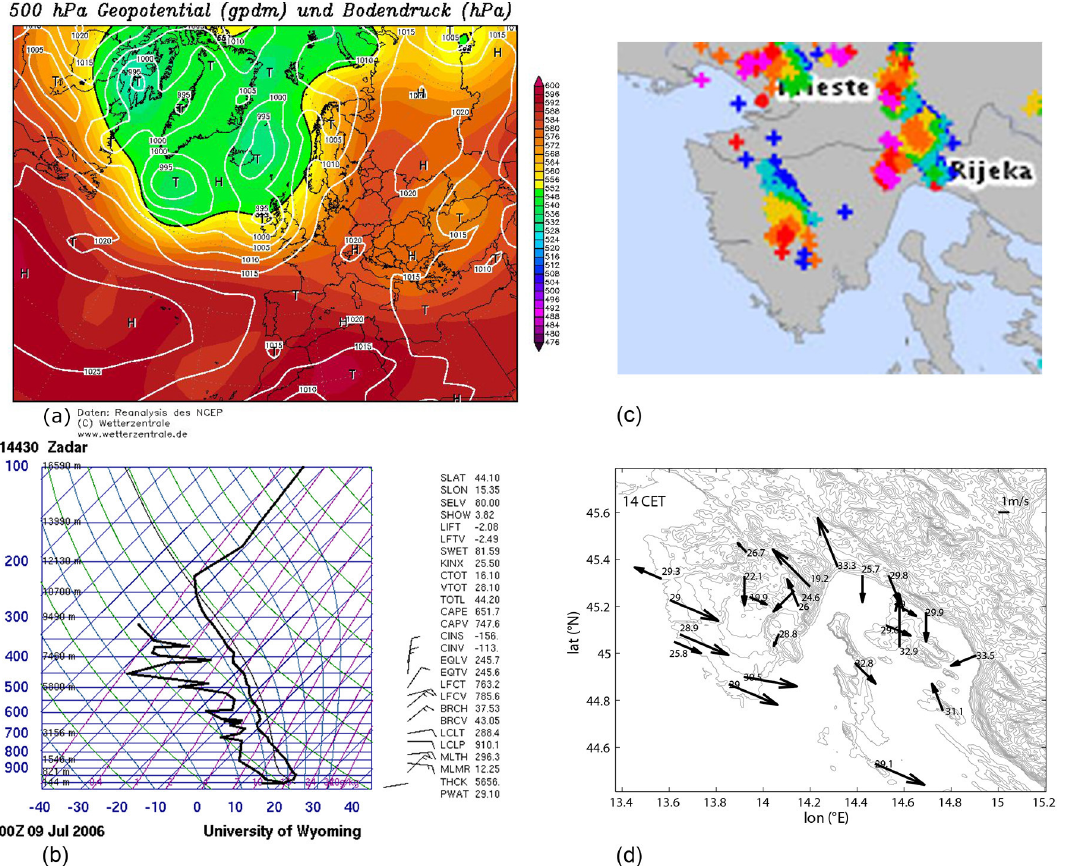
Fig. 3. Case C1, 9 July 2006: (a) surface pressure distribution (white lines) and geopotential of 500hPa pressure level (filled areas) at 00:00UTC (i.e. 01:00CET) (source: http://www.wetterzentrale.de/topkarten/fsreaeur.html). (b) Radio sounding profiles plotted on a skew T- log p diagram in combination with convective indices in Zadar (44.10 ◦ N, 15.35 ◦ E) at 00:00UTC (i.e. 01:00CET); (c) lightning distribution from 13 to 14:00CET from LINET network (Betz et al., 2009). The coloured crosses indicate the detection of lightning within one hour: purple (<3min), red (10–3min), orange (20–10min), yellow (30–20min), green (40–30min), light blue (50–40min) and blue (>50min); (d) the measured 10m wind vectors (ms − 1 ) and 2m air temperatures ( ◦ C) at 14:00CET (measuring sites in Fig. 1a). Table 2. Sea breeze (SB) characteristics and thermodynamical variables from the model averaged in time (for period of 10:00–12:00CET), over the Istria peninsula for four selected cases. Parameters were defined along the vertical cross-section (B1B2) shown in Fig. 1. In the table, abbreviations represent max SB speed=maximum wind speed in the western onshore flow usually between 200 and 300ma.g.l, SBF: sea breeze front and low-level MFC: moisture flux convergence (e.g. Eq. 5 in Banacos and Schultz, 2005). Inland penetration of the SB and SBF height are determined by the position of the SBF updraft. A negative divergence ( ∂u/∂x + ∂v/∂y <0) in the table means maximum horizontal convergence value associated with